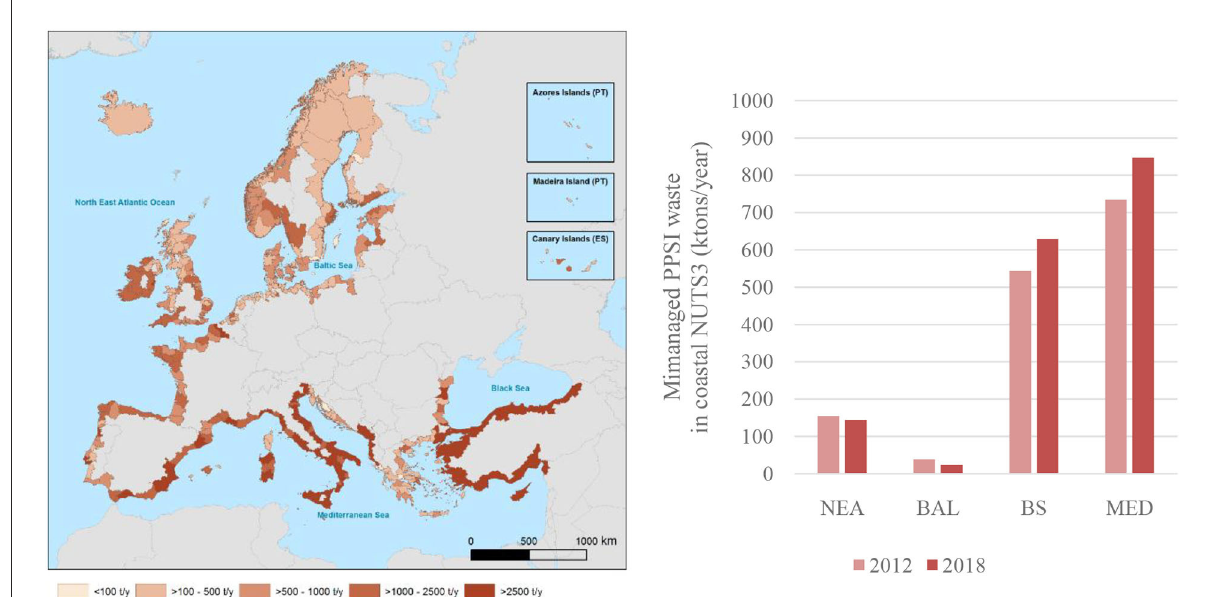
FIGURE7 Amounts of mismanaged PPSI waste in 2018 in coastal NUTS 3 (tons per year, t/y) (left) ; and total amounts in NUTS 3 (thousand tons per year, ktons/year) aggregated by European regional sea in 2012 and 2018 (right) : North-East Atlantic Ocean (NEA, including the Atlantic archipelagos of Azores, Madeira, and Canary Islands), Baltic Sea (BAL), Black Sea (BS), and Mediterranean Sea (MED). PPSI, plastic packaging and small non-packaging plastic